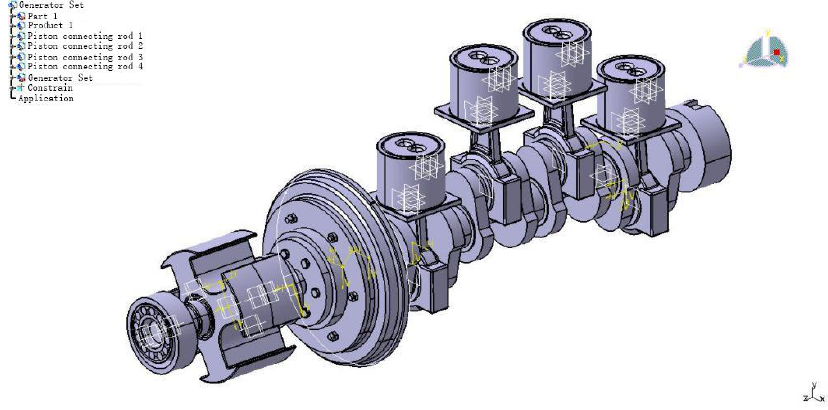
Figure 17. Three-dimensional solid model of range extender.